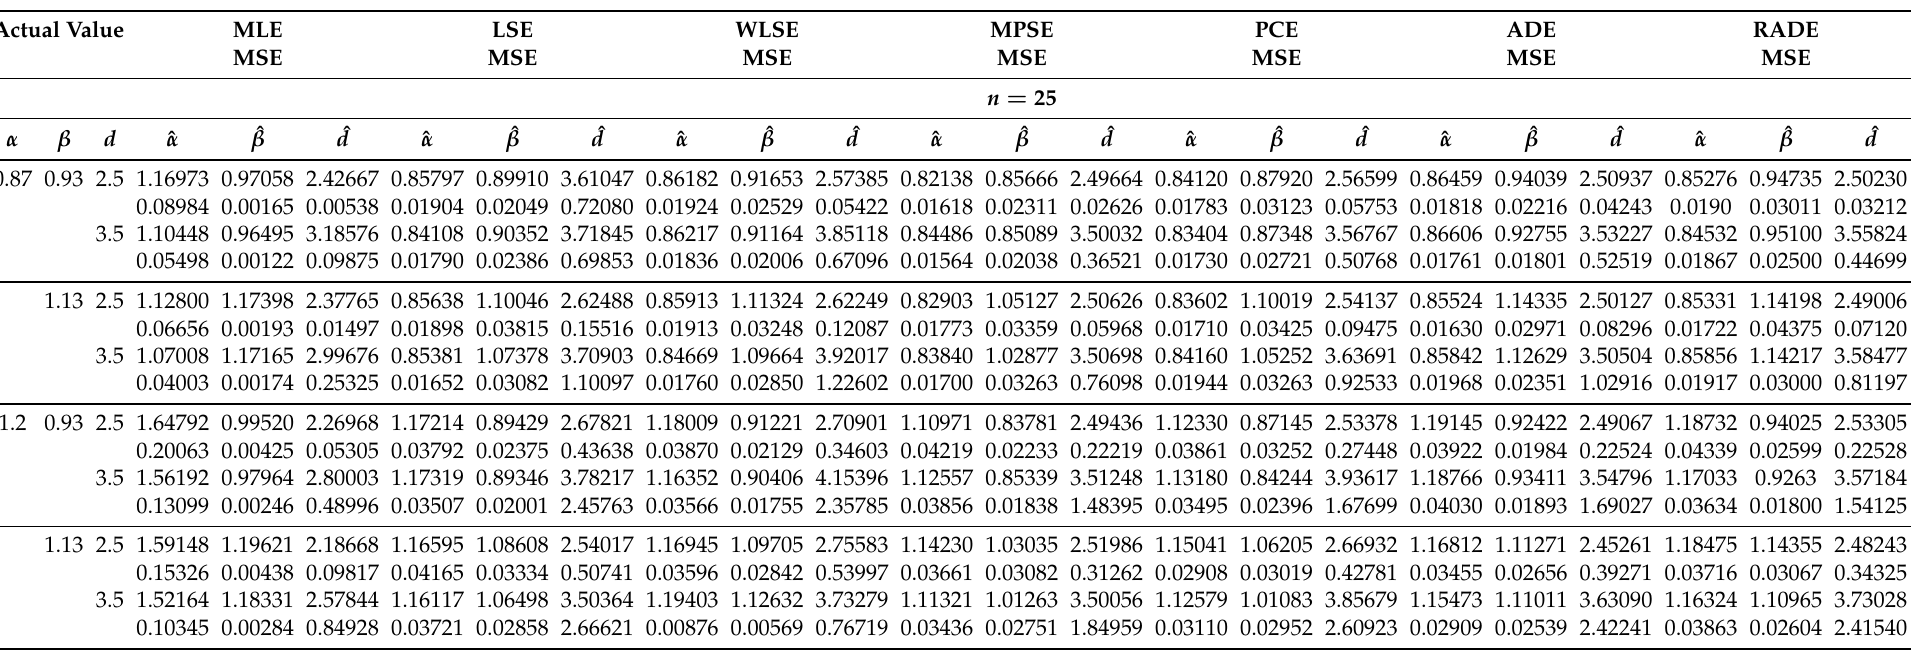
Table 6. The MLEs, LSEs, WLSEs, MPSEs, PCEs, ADEs, RADEs and their